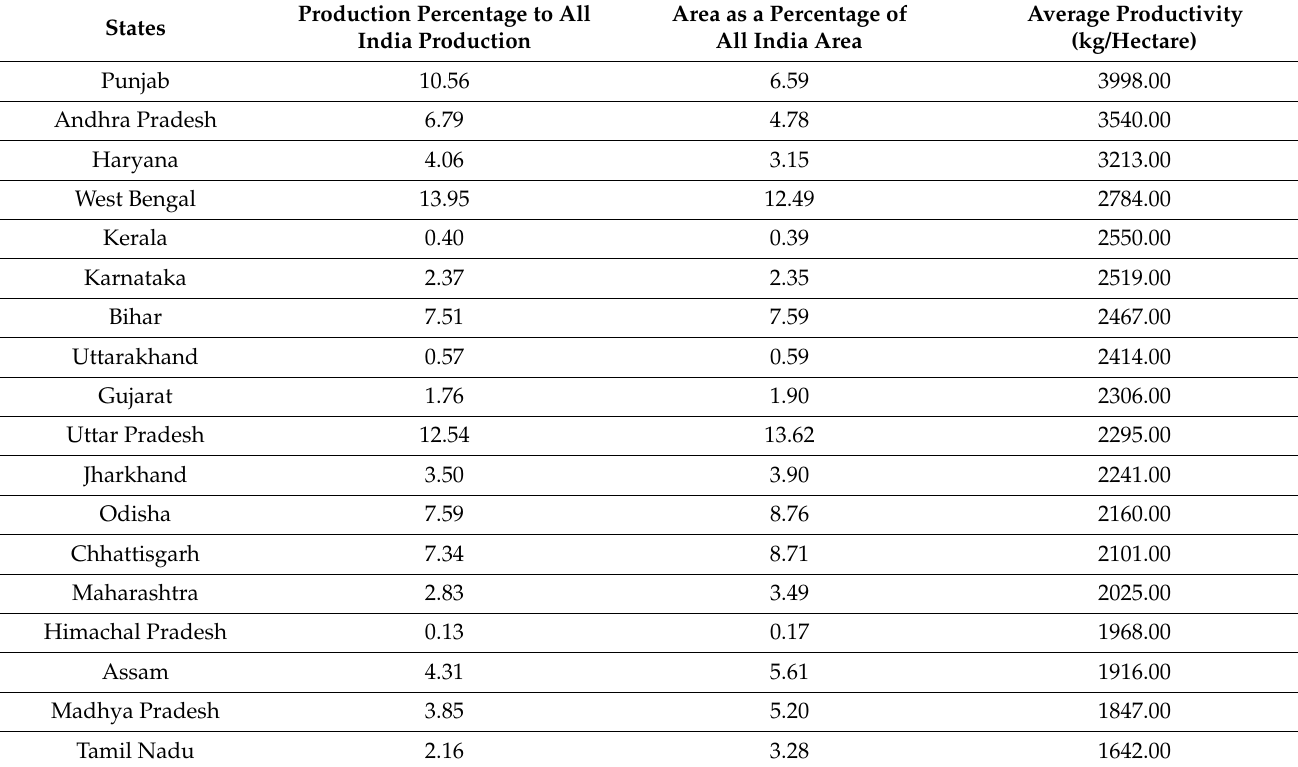
Table 3. State-wise area, production and productivity for paddy crops in India for 2016–2017. States